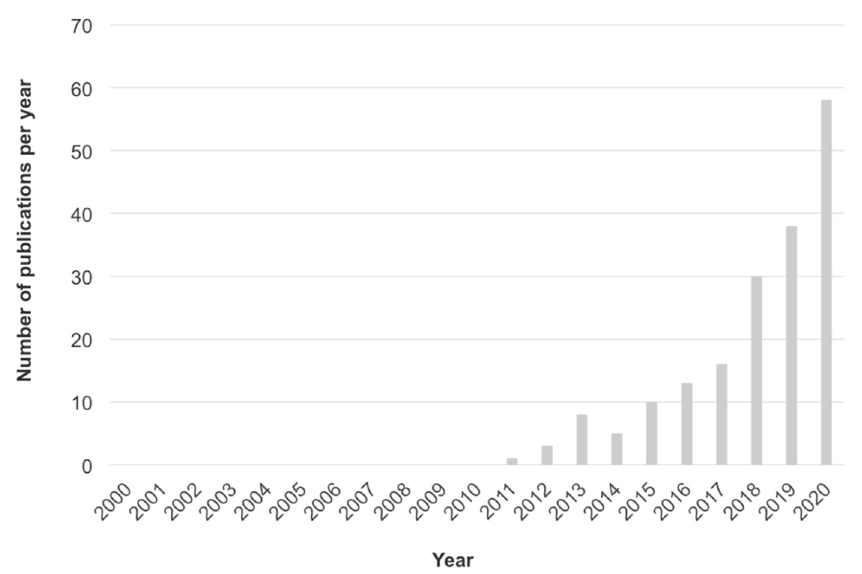
Figure 1. Trend in the number of publications using the search terms “healthy and sustainable diet”, “sustainable and healthy diet”, “sustainable diet” and “healthy diet”, “sustainable healthy diet”, “healthy sustainable diet” published from 2000–2020, excluding 2021, and listed on Scopus, Web of Science and PubMed (28 February 2021). Table 1. Specific keywords used in the different domains in the literature review. Nutrition and